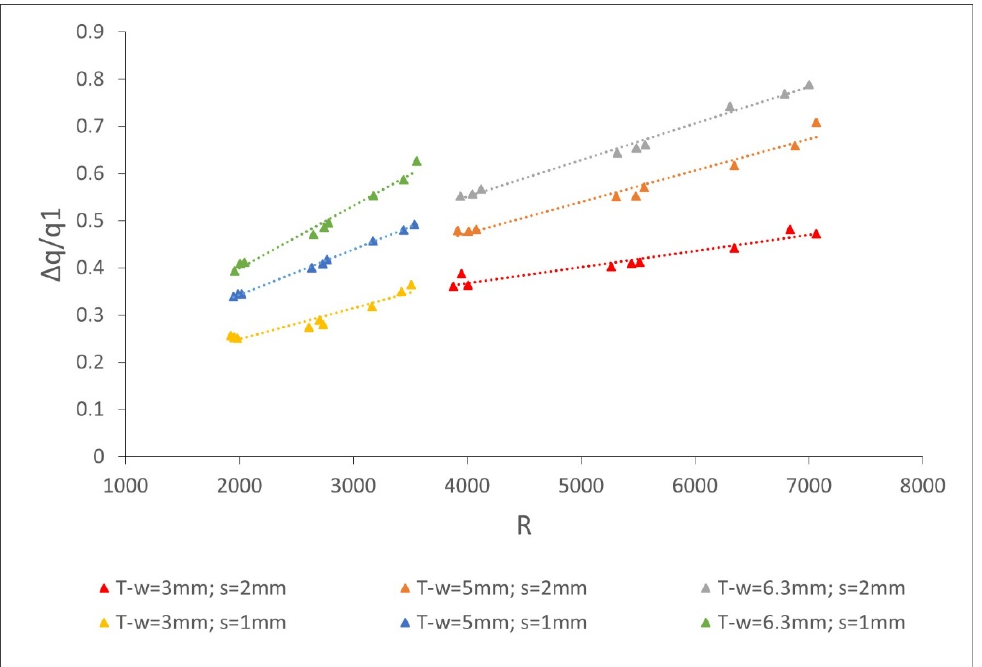
Figure 15. Relations for triangular wire screen between Δ q / q 1 and Reynolds number .